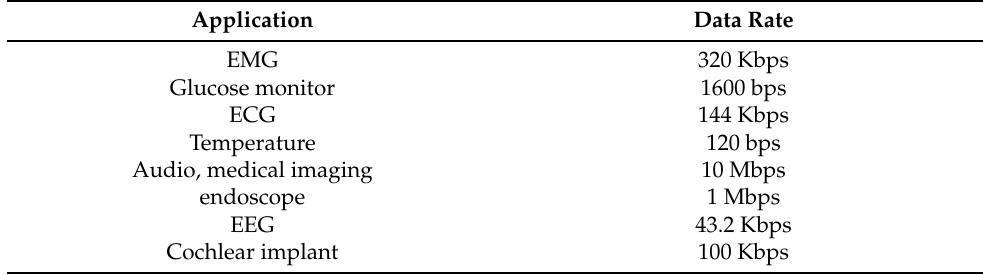
Table 5. Data rate for different